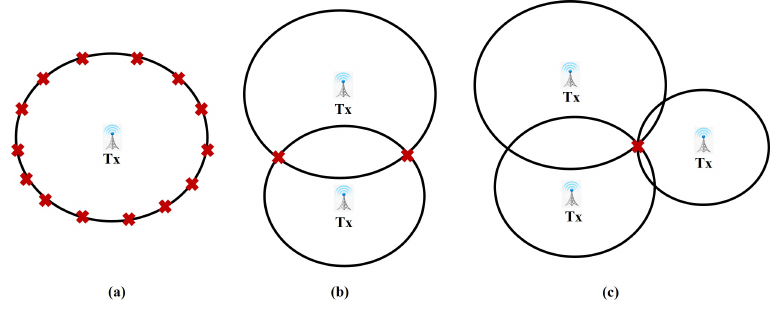
Figure 4. Trilateration localization technique. ( a ) The receiving node can be located anywhere on the circle circumference; ( b ) the receiving node can only be located on any of the two intersection points; ( c ) the receiving node can only be located on the intersection of the three